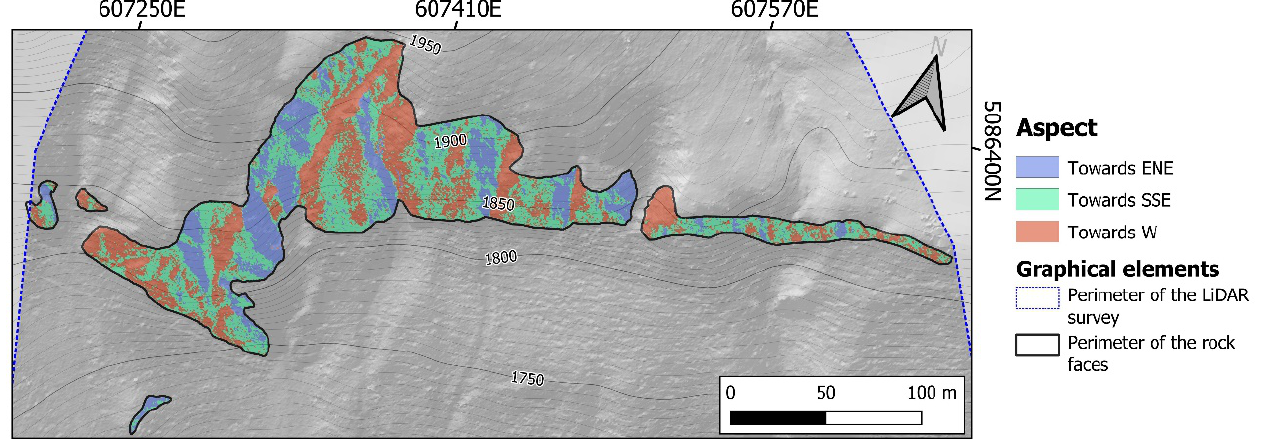
Figure 7. Slope and aspect of the rock faces only.